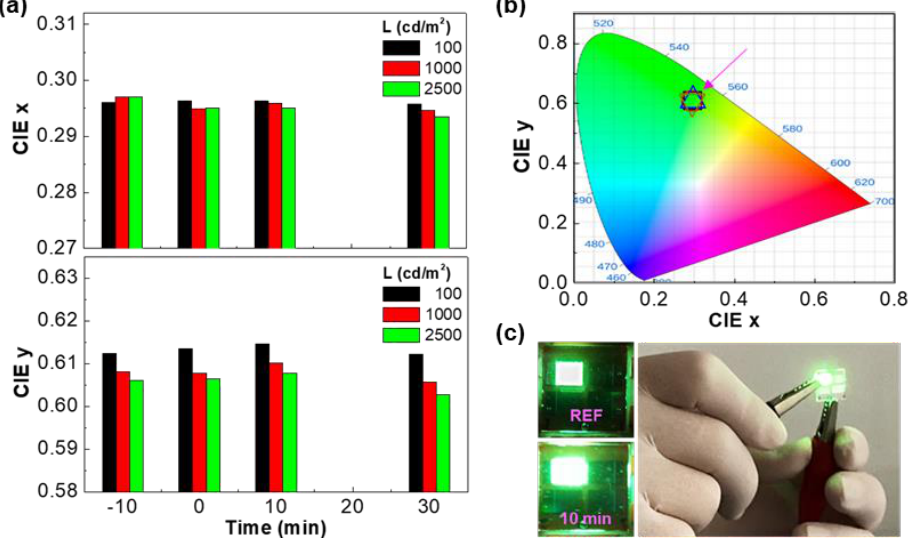
Figure 6. ( a ) CIE x and y coordinate values as a function of thermal annealing time for the OLEDs with the P3HT layers annealed at 140 ◦ C at three different levels of luminance (L = 100, 1000, 2500 cd/m 2 ). ( b ) CIE color coordinate diagram from the x and y values at L = 1000 cd/m 2 in ( a ): Note that the symbols pointed by the pink arrow overlap each other. ( c ) Photographs for the green light emission devices at 10 V: ( left ) comparison between REF-OLED and 10 min-OLED, ( right ) 10 min-OLED at 15